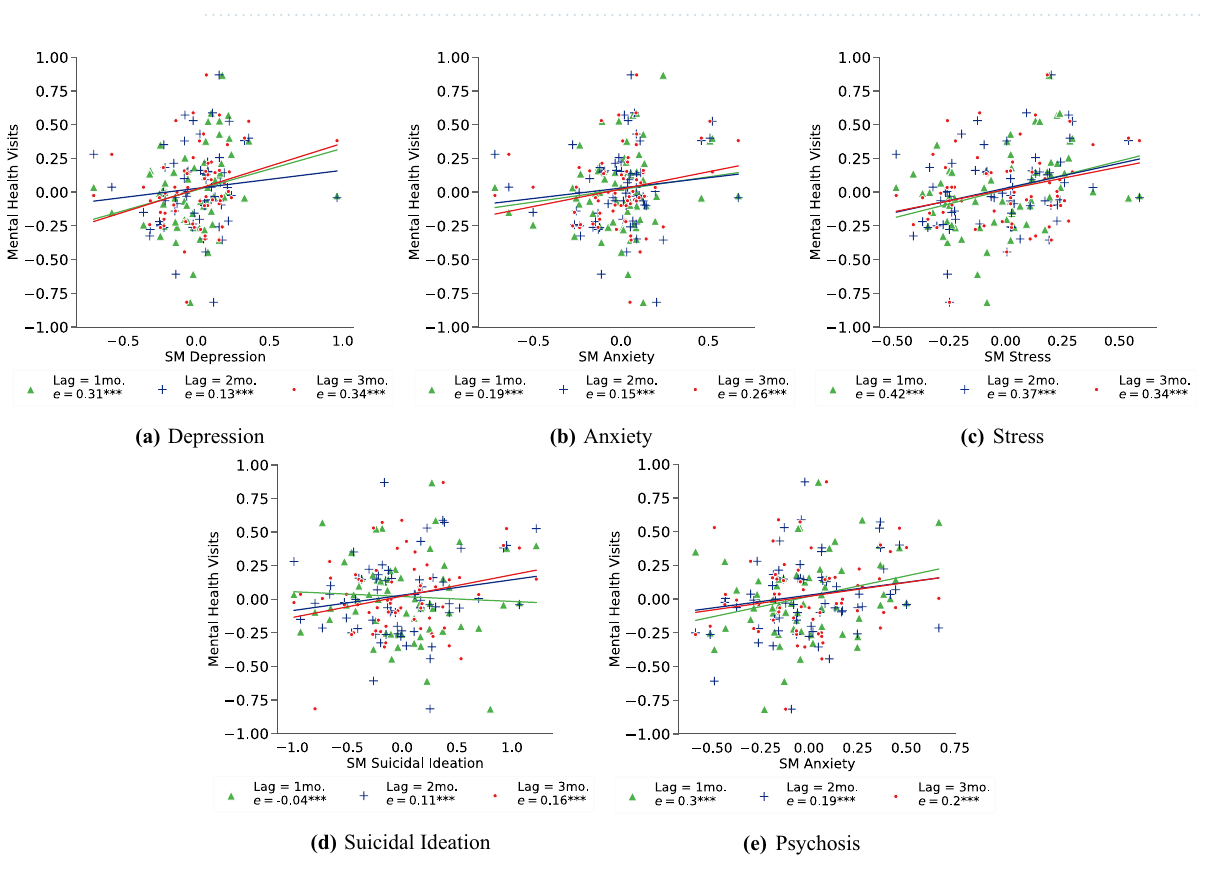
Figure 1. Temporal evolution of the normalized prevalence of social media expressions indicative of mental health symptomatic outcomes on the college subreddit.